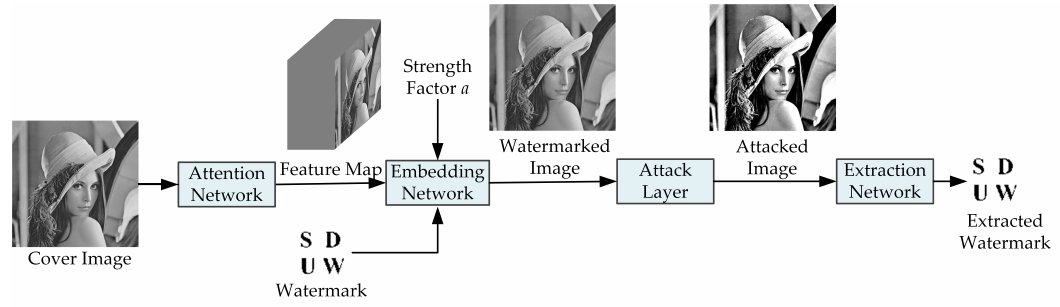
Figure 1. Flow chart of DARI-Mark.